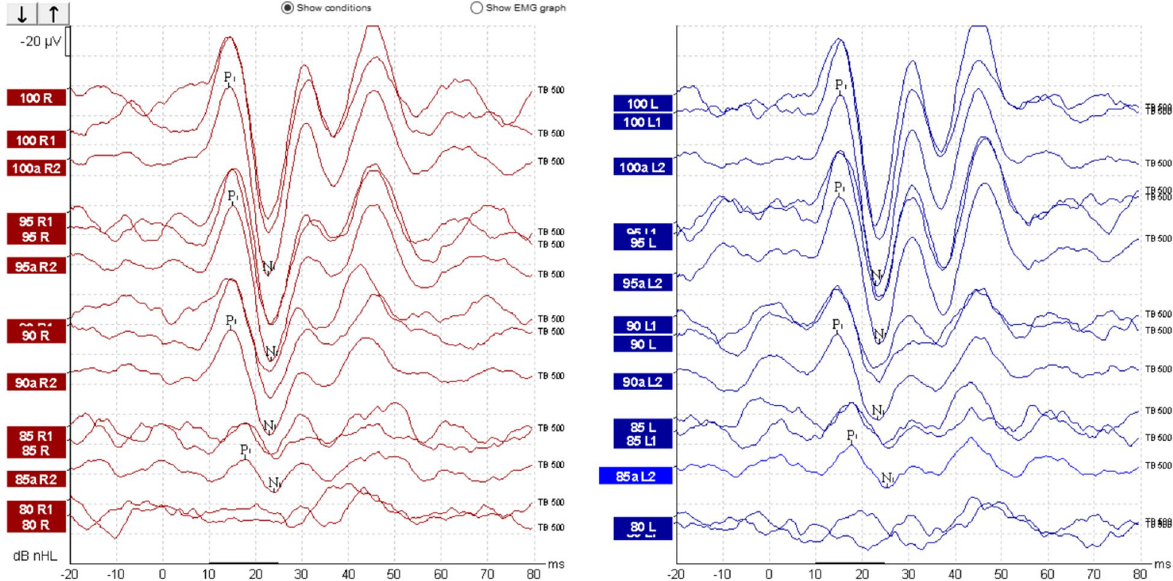
Fig. 2 It is the cVEMP response of the same individual cVEMPs responses were obtained from the same female individual. (cVEMPs responses, right and left ear VEMPs threshold 85 dB